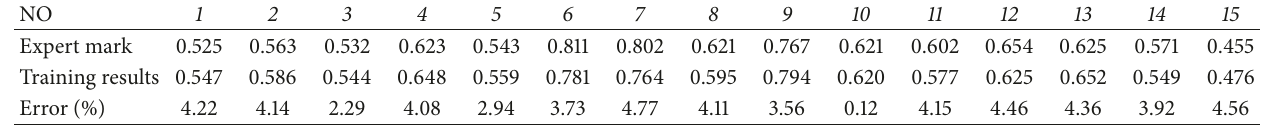
Table 10: BP neural network results of training on railway construction risks in 15 European countries.